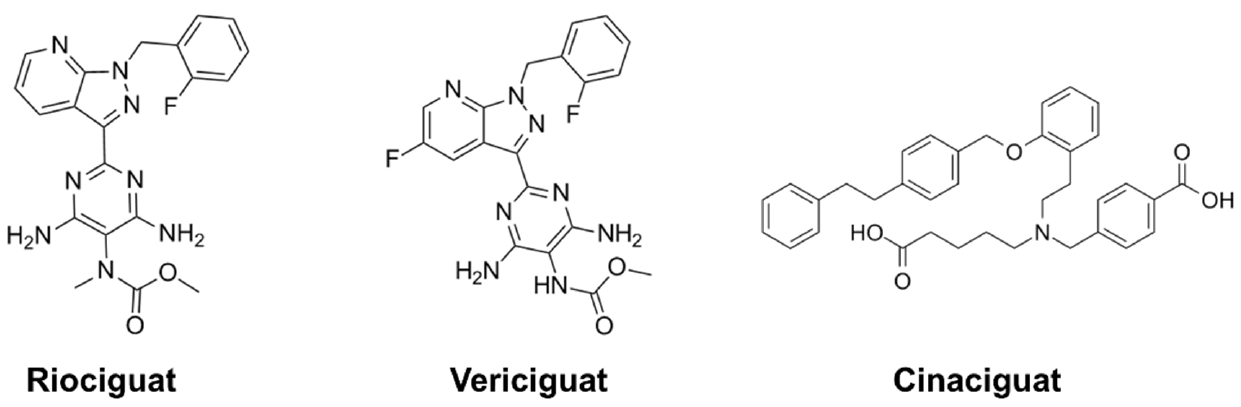
Figure 2. Chemical structures of selected sGC stimulators.